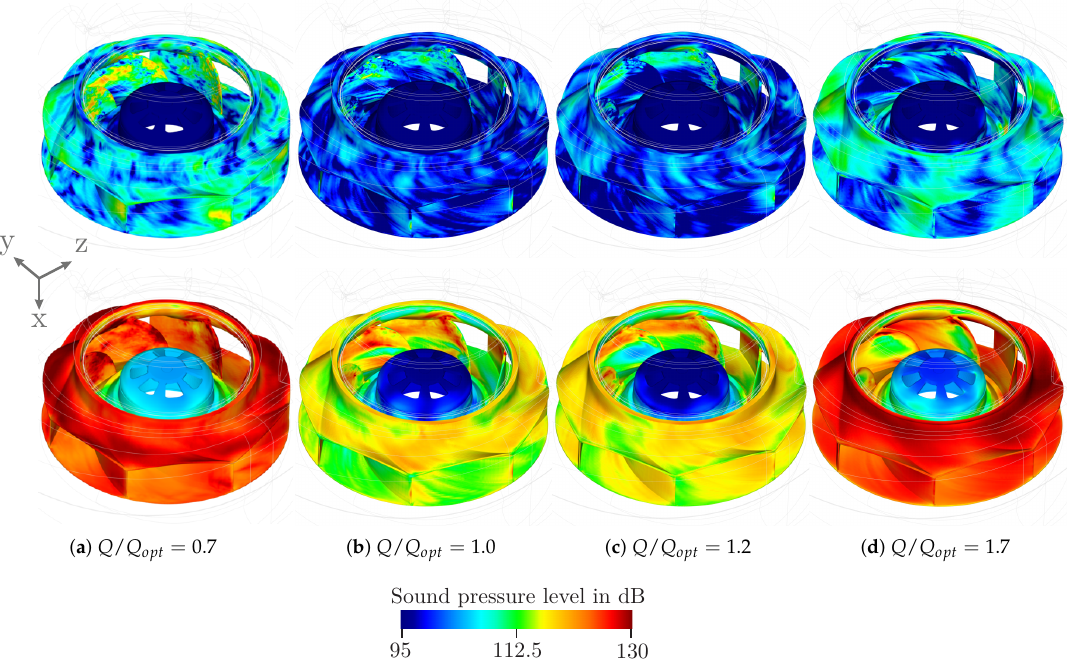
Figure 17. Wall sound pressure level of impeller filtered around BPF ( top ) and in a broadband range of 100–2500 Hz ( bottom